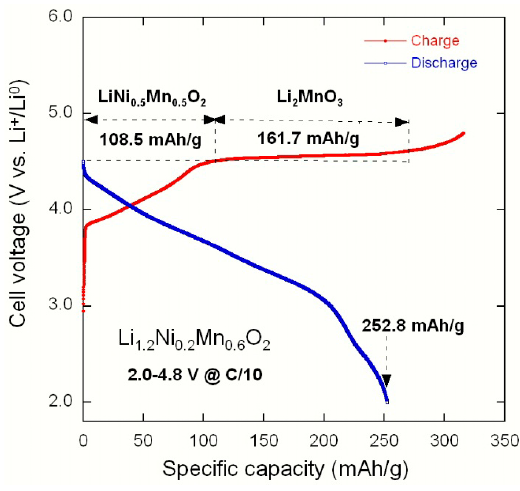
Figure 22. The first charge–discharge profile of a Li//Li 1.2 Ni 0.2 Mn 0.6 O 2 cell cycled at C/10, showing the mechanism of the activation of Li 2 MnO 3 and LiNi 0.5 Mn 0.5 O 2 components.